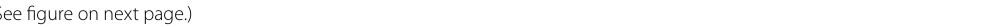
(See figure on next page.) Fig. 6 ALT detection in paediatric tumor samples. a Representative images for denaturing telomeric FISH in sections from paediatric tumors and adult LB857 Tumor /ALT + section. Scale bars: 5 μm. b Representative images for ultra-bright telomeric signals identified in the paediatric PT12 Tumor , PT4 Tumor , PT20 Tumor tumor sections and in the LB857 Tumor section from adult ALT + tumor. Scale bars: 5 μm. c Representative images of native FISH signals in the same tissues as in b , as well as in the PT16 Tumor /TEL + tumor section used as negative control. The quantification of the native FISH experiment performed in all the paediatric tumors is shown below as frequency of nuclei scored as 0 (grey), 1 (pink) or more than 1 (green) ss-TeloC signals per nucleus. Single experiment in which at least 140 nuclei were quantified. Scale bars: 5 μm. d Representative images of native FISH signals in sections from melanoma tumors with either active telomerase (TEL + tumors: LB2805, LB2813, LB2840, LB3110) or no detectable TMM (TMM neg tumors: LB2901, LB3129) [27]. Native FISH assay was also performed on sections from normal human skin or tonsils. Scale bars: 5 μm. e Slot-blot of the C-circle assay with ( Φ29) or without ( Φ29) Phi29 DNA polymerase performed on FFPE PT12 Tumor , PT4 Tumor , PT20 Tumor and frozen LB857 Tumor + − samples, as well as FFPE PT16 Tumor /TEL + used as negative control. We also included the FFPE TEL + and ALT + xenograft tissues as, respectively, negative and positive controls. Quantification is shown below ( n =